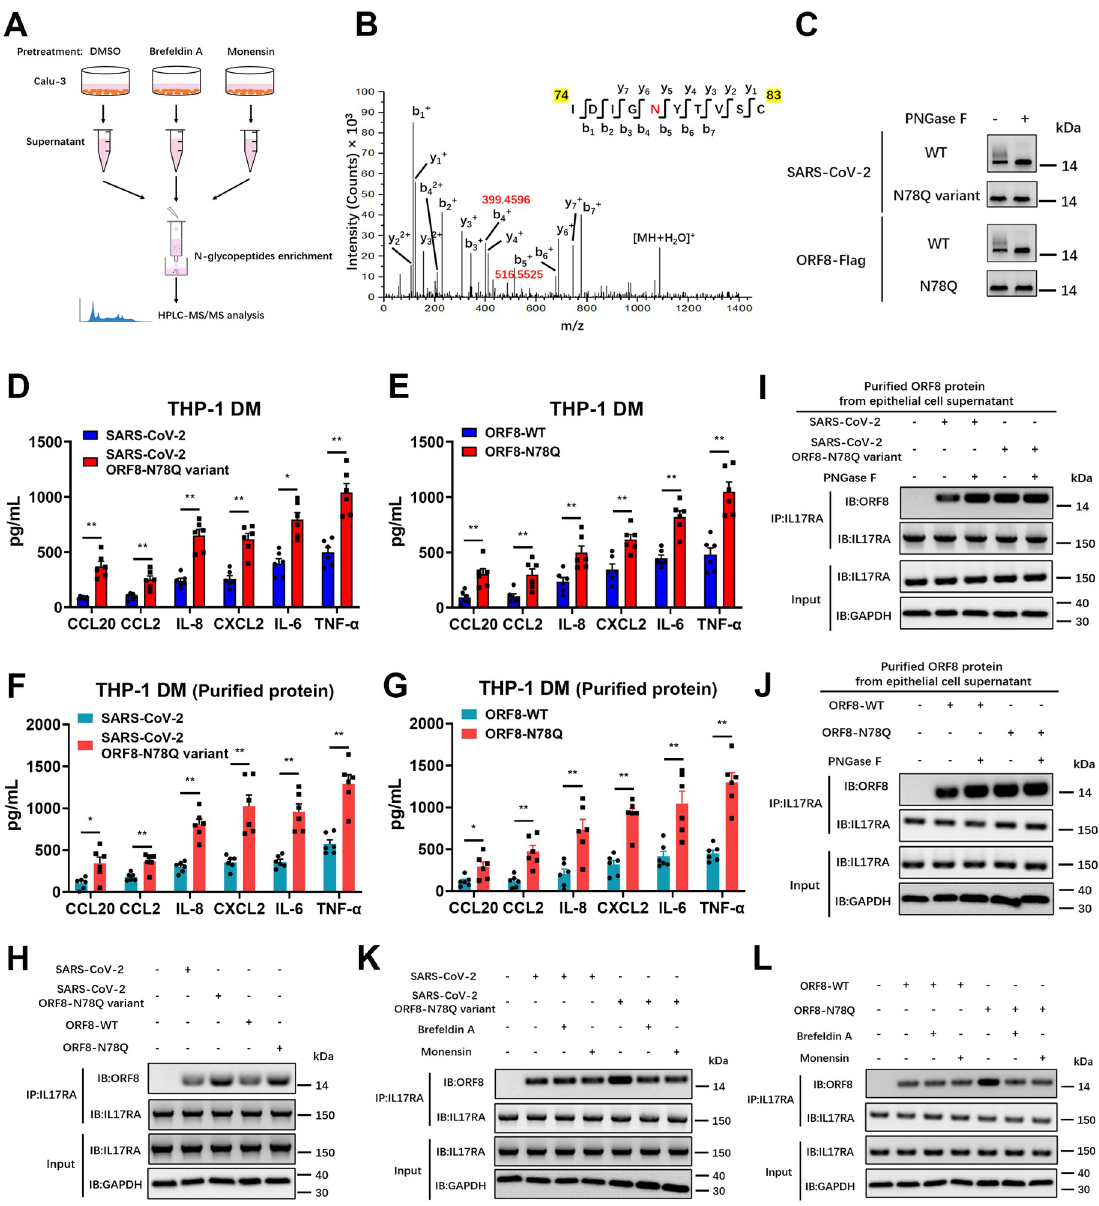
Fig 4. ORF8 N78 glycosylation blocks its interaction with IL17RA. (A) Schematic diagram of glycosylation identification based on HLPC-MS/MS. DMSO (control), Brefeldin A (3 μ g/mL) or Monensin (2 μ M) was used to pretreat Calu-3 cells for 2 hours. The supernatant was collected for HLPC-MS/MS analysis. (B) SARS-CoV-2 ORF8 secreted through conventional pattern has N78 glycosylation. An increase of 2.9890 Da of Asn residue was used to determine N-linked glycosylation. (C-G) Calu-3 cells were infected with SARS-CoV-2 ORF8-N78Q variant (C, D, F), or transfected with ORF8 N78Q plasmid (C, E, G). After 12 hours, the supernatant was collected and divided into three parts. One part was used to purify ORF8 protein, followed by PNGase F digestion and western blotting (C); the second part was used to stimulate THP-1 DM cells (D, E); the third part was used to purified ORF8 protein and then stimulate THP-1 DM cells at a final concentration of 10 ng/mL (F, G). After 12 hours, the release of cytokines and chemokines was detected by ELISA (D-G). (H) Calu-3 cells were infected with SARS-CoV-2 ORF8-N78Q variant, or transfected with ORF8-N78Q plasmid. Twelve hours later, the supernatant was used to stimulate THP-1 DM cells for another 12 hours. The interaction of ORF8 and IL17RA was detected by co-immunoprecipitation. (I, J) Calu-3 cells were infected with SARS-CoV-2 ORF8-N78Q variant (I), or transfected with ORF8-N78Q plasmid (J). After 12 hours, the supernatant was collected to purify ORF8 protein. After PNGase F digestion, the ORF8 protein was used to stimulate THP-1 DM cells for 12 hours, and the interaction of ORF8 and IL17RA was detected by co- immunoprecipitation. (K, L) Brefeldin A or Monensin was used to pretreat Calu-3 cells for 2 hours, followed by infection with SARS-CoV- 2 ORF8-N78Q variant (K), or transfection with ORF8-N78Q plasmid (L). Twelve hours later, the supernatant was used to stimulate THP-1 DM cells for another 12 hours. The interaction of ORF8 and IL17RA was detected by co-immunoprecipitation. Representative